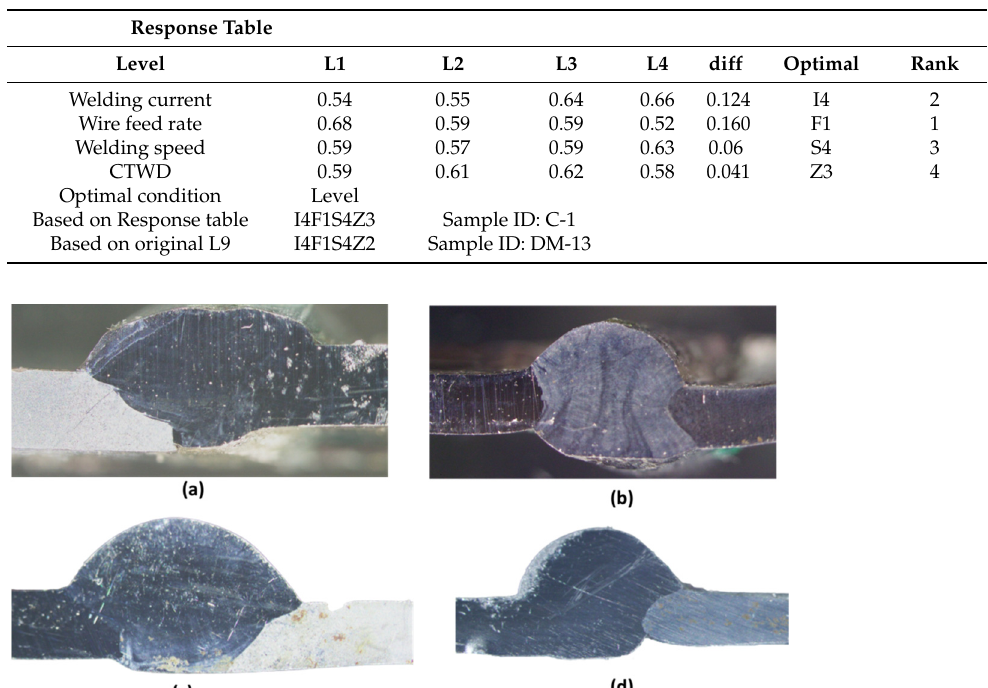
Table 4. Response table for average GRG.